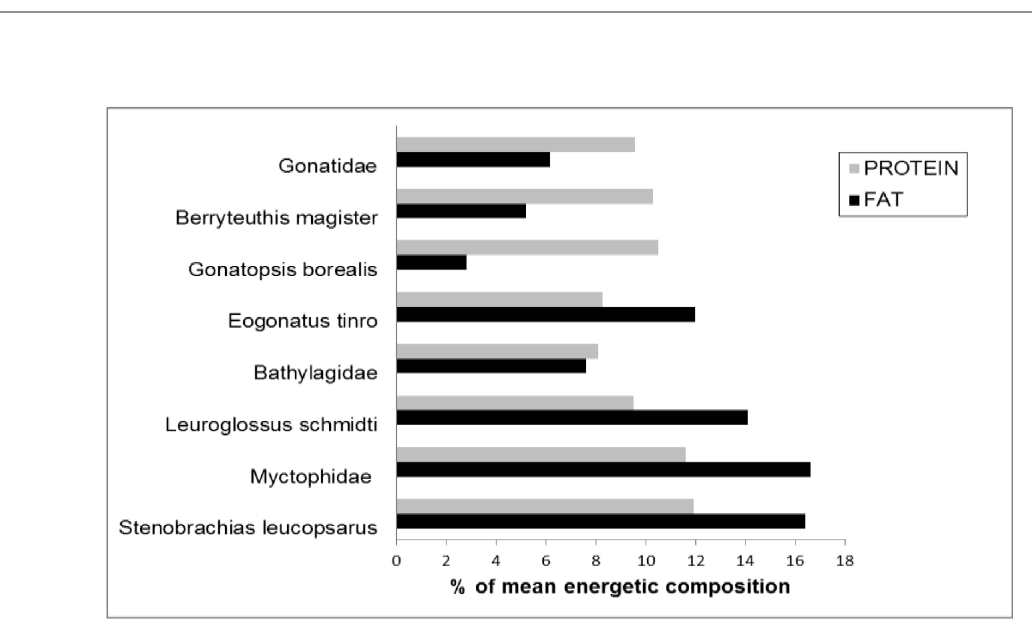
Fig 1. Size-related energetic content. Relative size related energy content of dominant fish and squid families and species caught in Bering Sea research trawls during 1999 and